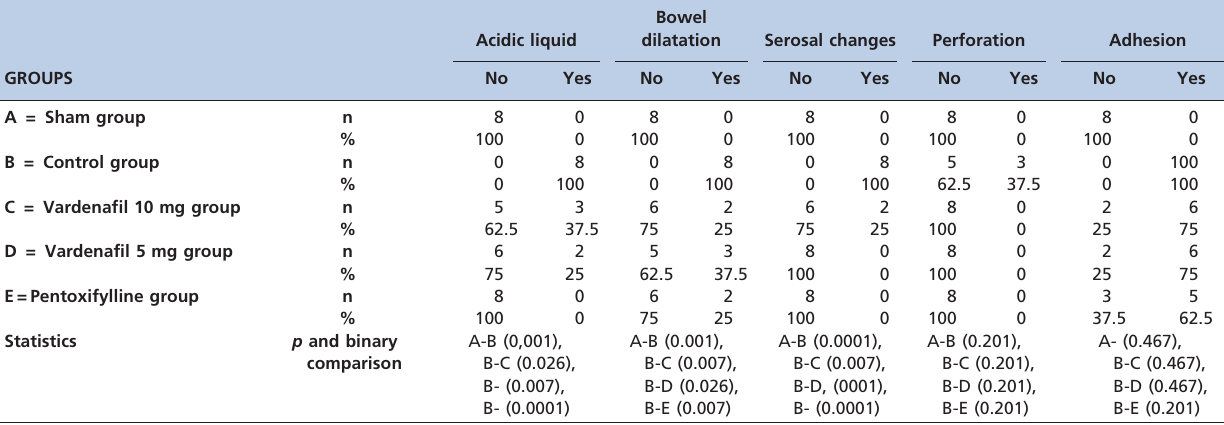
Table 2 - Comparison of macroscopic damage between groups.